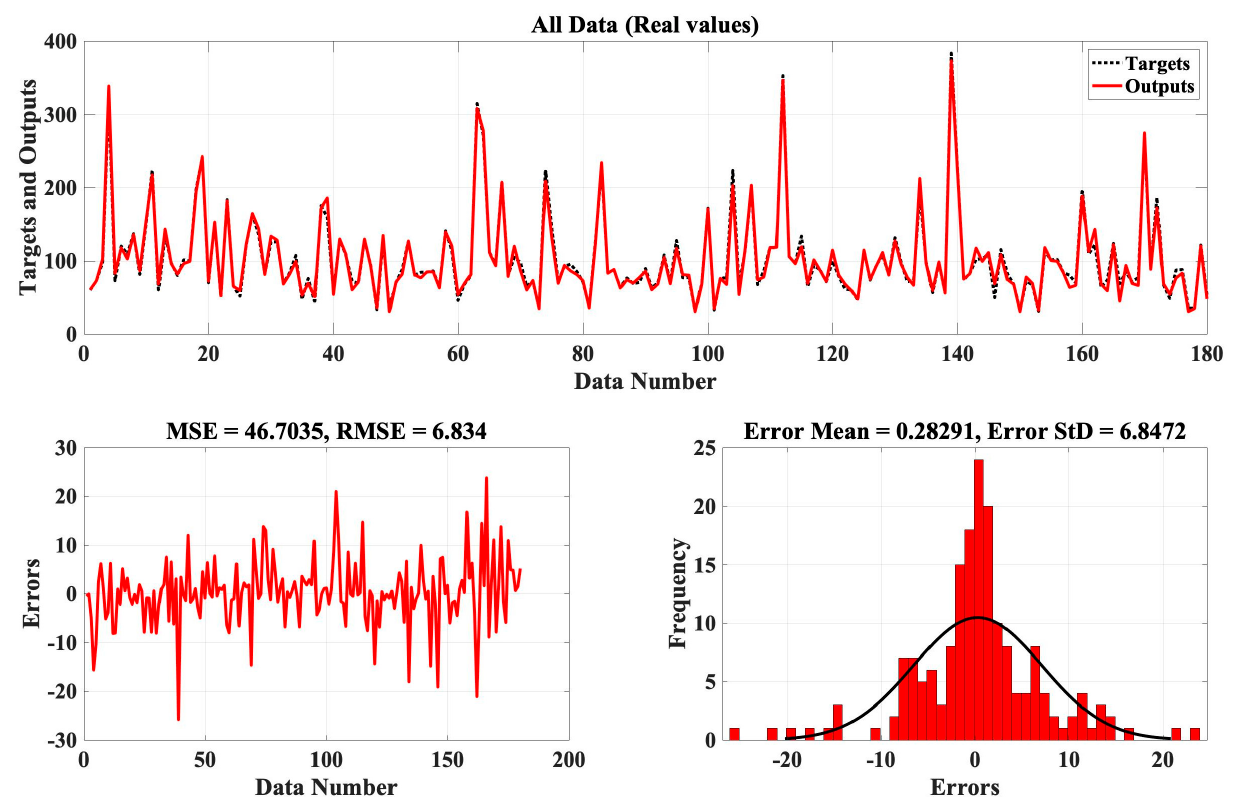
Figure 11. Results of the whole database.